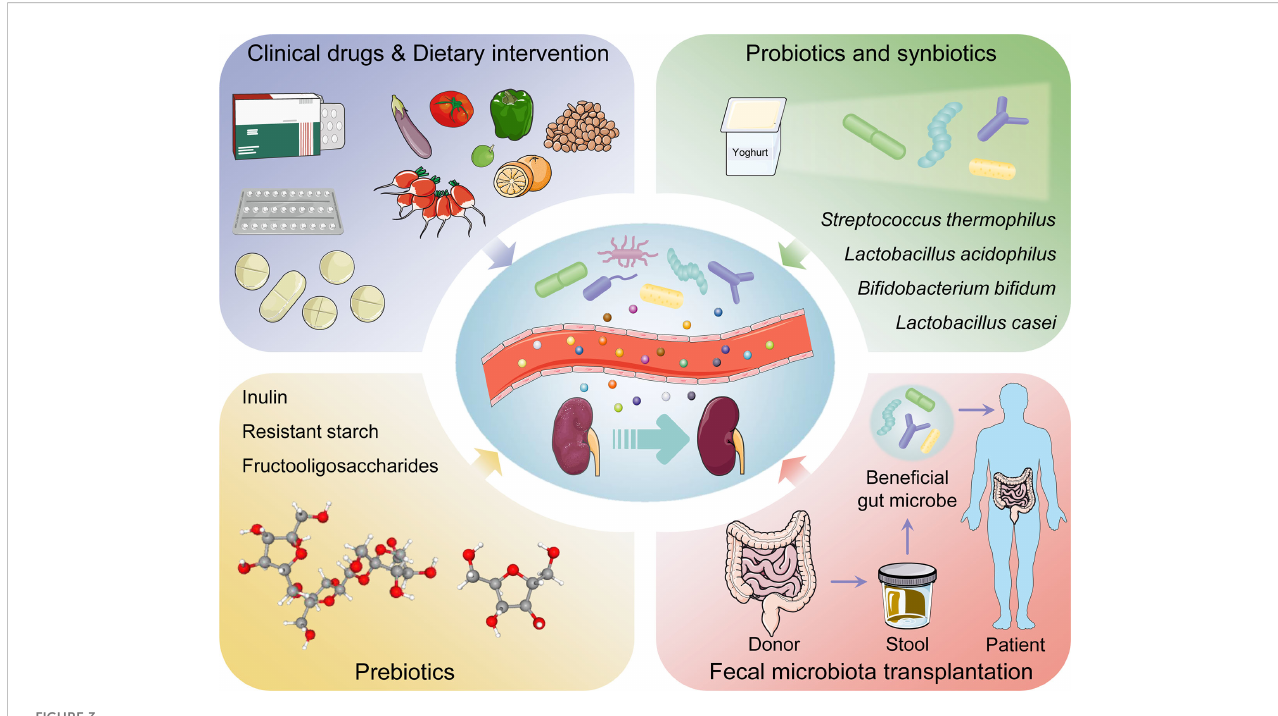
FIGURE 3 The management and therapeutic strategies of diabetic kidney disease based on gut